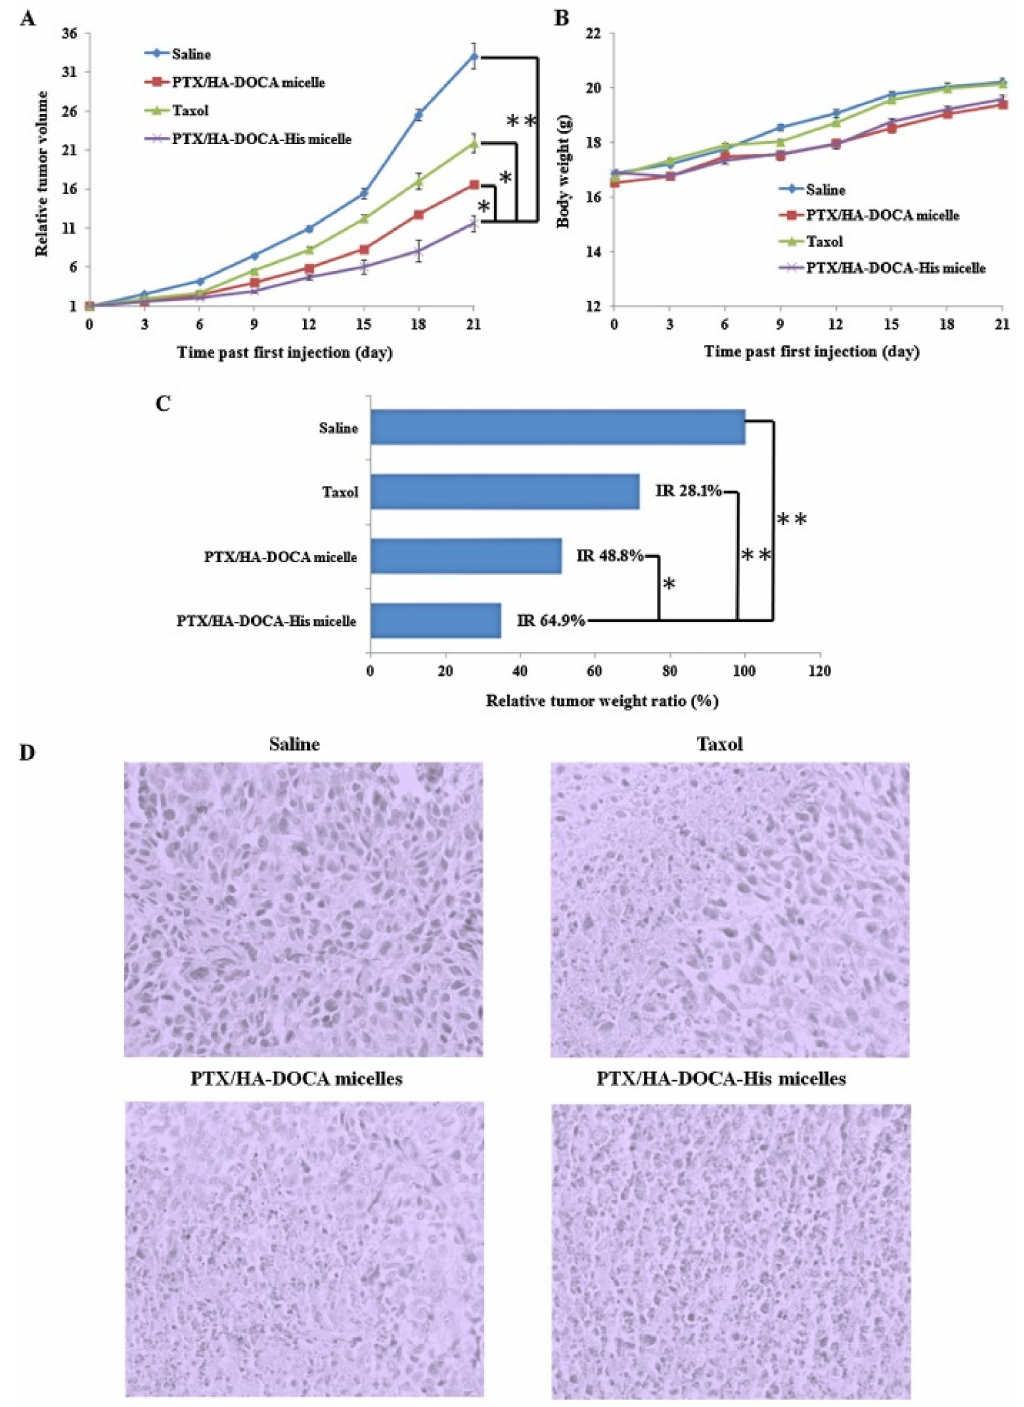
Figure 6. In vivo antitumor activity of Taxol, PTX/HA-DOCA, and PTX/HA-DOCA-His micelles in a multidrug-resistant human breast carcinoma MCF-7/Adr tumor model with saline as a control group. ( A ) Relative tumor volume changes of different treatments with time past first injection (mean ± SE, n = 5). * p < 0.05, ** p < 0.01 (PTX/HA-DOCA-His micelles vs. other treatment). ( B ) Changes of body weight in mice following different treatments. ( C ) Measured tumor weights after excision, plotted as relative tumor weight ratio. Tumor growth inhibition rate (IR, %) was calculated as: (1- (mean tumor weight of drug treated group/mean tumor weight of saline treated group)) × 100. ( D ) Histological analyses of tumor tissues treated with saline, Taxol solution, PTX/HA-DOCA, and PTX/HA-DOCA-His micelles collected on day 20 using H&E staining